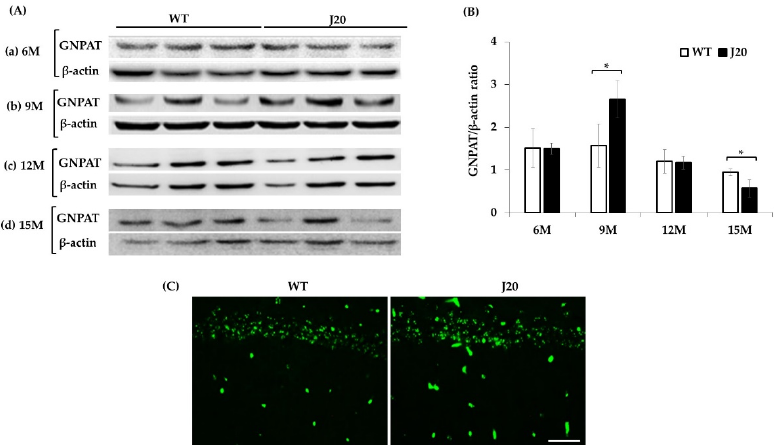
Figure 3. Time-dependent change of GNPAT protein expression in the hippocampus of WT and J20 mice. Total GNPAT expression levels of WT and J20 were evaluated by Western blotting, as described in the Materials and Methods. Repre- sentative Western blotting data at the age of 6 M ( A . a ), 9 M ( A . b ), 12 M ( A . c ), and 15 M ( A . d ) are shown. Densitometric analyses are shown ( B ). The expression and localization of GNPAT reactivity was checked by immunofluorescence stain- ing at 9 months. Representative photomicrographs of GNPAT protein expression are shown ( C ). The numerical data ex- pressed as average ± SD of 3 mice in a group. Statistical significance is denoted as follows: * p < 0.05. Scale bar = 50 μ m ( C ). M indicates months.